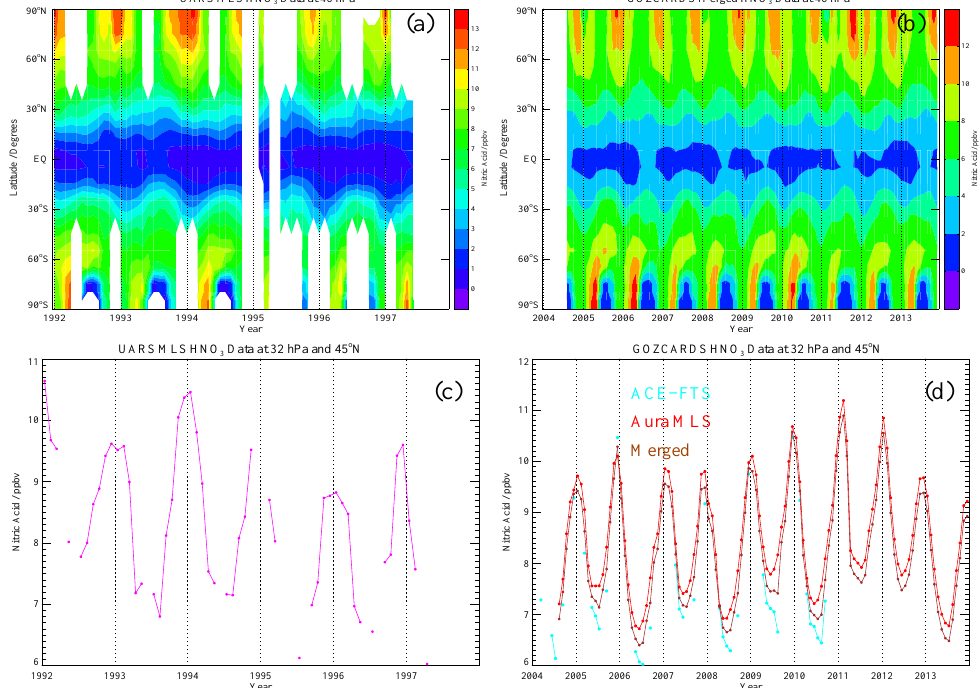
Figure 24. Sample results display the time evolution of satellite-retrieved HNO 3 (ppbv) for two different periods: 1992–1997 in (a) and (c) versus 2004–2013 in (b) and (d) . Panels (a) and (b) are contour plots at 46hPa from UARS MLS global data and the merged GOZCARDS global data after 2004, respectively; (c) and (d) show time series at 32hPa and for the 40–50 ◦ N latitude bin, with (c) from UARS MLS data, and (d) from ACE-FTS, Aura MLS, and the merged combination (between the two source data sets).